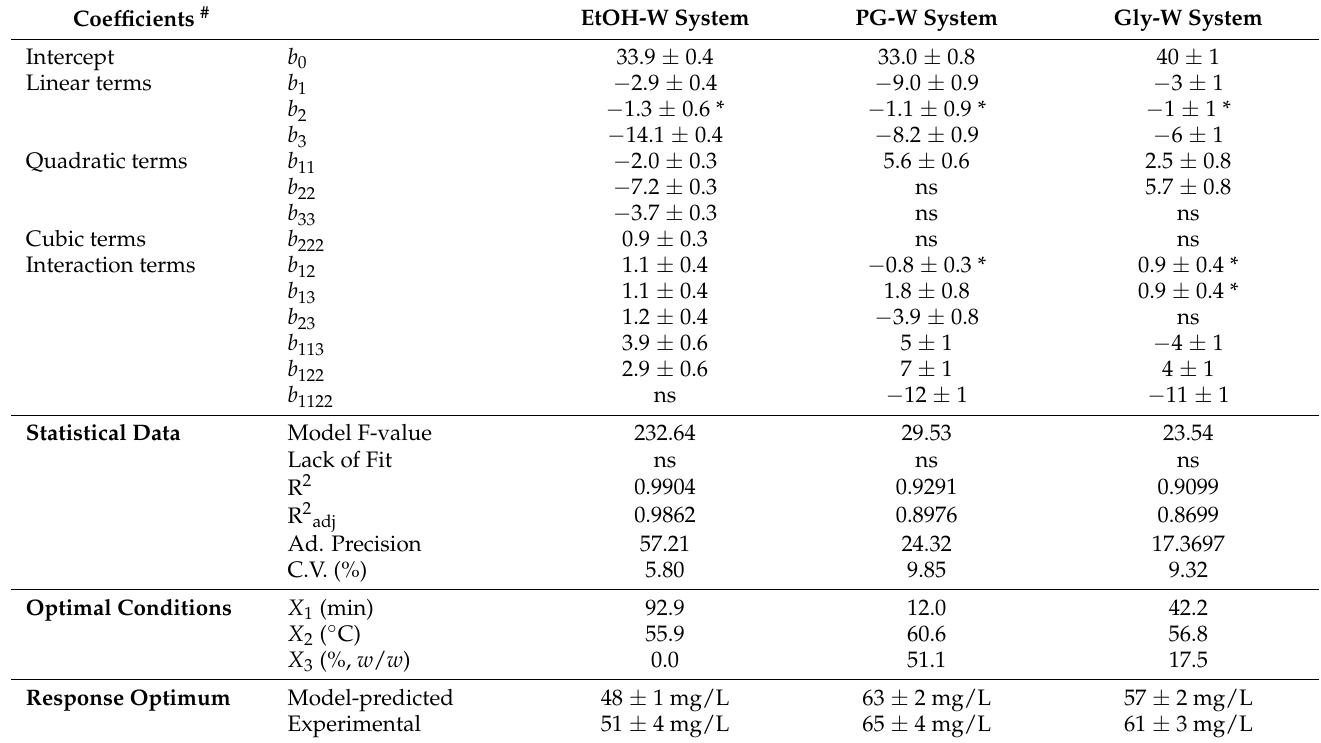
Table 2. Parametric coefficients, statistical information of the model fitting procedure, and optimal processing conditions in natural values that lead to optimal response values of aloesin for each alcohol–water